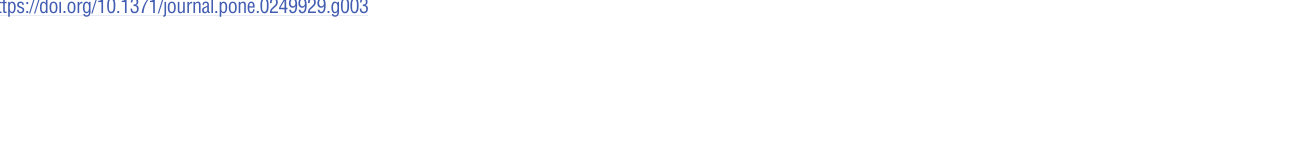
PLOS ONE | https://doi.org/10.1371/journal.pone.0249929 April 14,